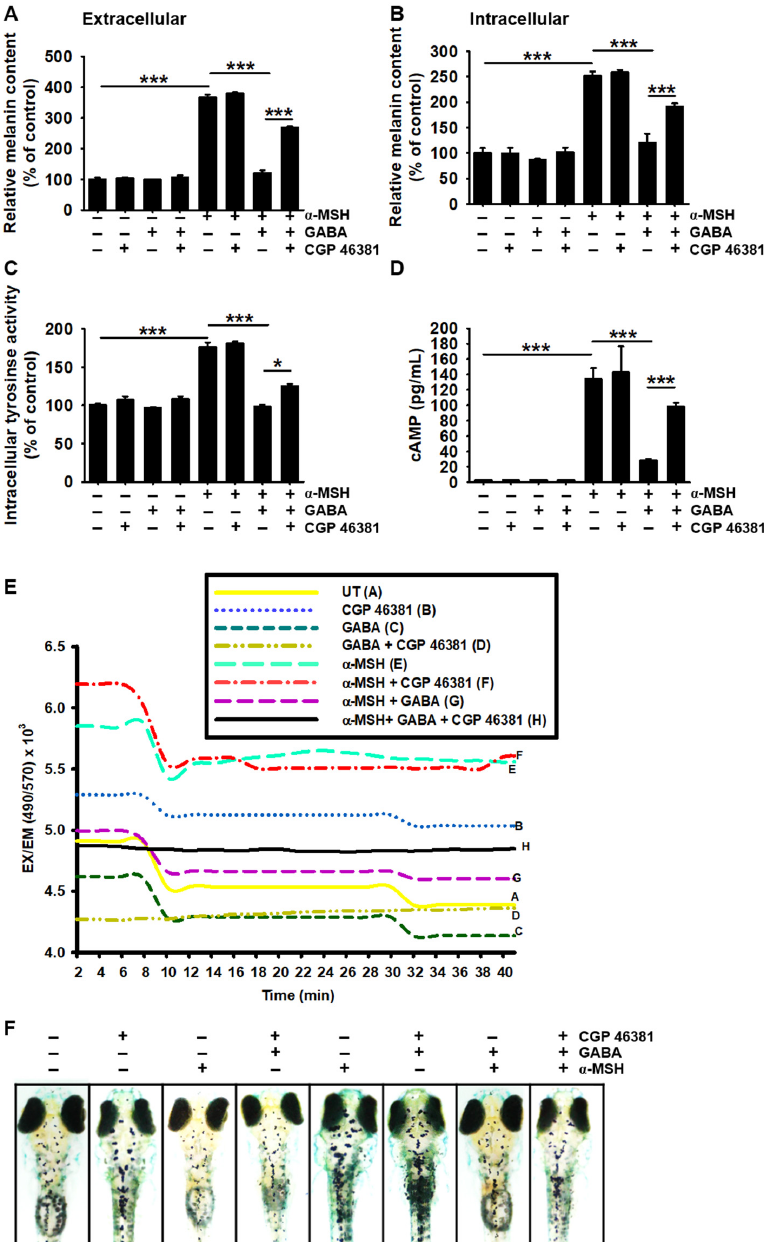
Figure 6. CGP 48381 reverses GABA-induced antimelanogenic effects in B16F10 melanoma cells and zebrafish larvae. B16F10 melanoma cells (5 × 10 4 cells/mL) were pretreated with 10 µ M CGP 46381 for 2 h prior to treatment with 20 mM GABA and 500 ng/mL α -MSH. Extracellular ( A ) and intracellular ( B ) melanin contents were measured. ( C ) Intracellular tyrosinase activity was measured 72 h after treatment with GABA and α -MSH, and ( D ) cAMP level was determined at 15 min. ( E ) The cells were stained with 1 µ M Fluo-4 AM for 10 min after treatment with GABA and/or α -MSH for 1 h, and fluorescence intensity was measured for 40 min using a luminometer. ( F ) Three days post-fertilized zebrafish larvae were pretreated with 10 µ M CGP 46381 for 2 h before treatment with 50 mM GABA and/or 1 µ g/mL α -MSH for an additional 72 h. Images were captured using a stereomicroscope (4 × ). The results represent the average of data obtained from three independent experiments and are expressed as the mean ± standard error of the mean (SEM) (*** p < 0.001 and * p < 0.01). GABA, gamma-aminobutyric acid; α -MSH, α -melanocyte-stimulating hormone; cAMP, cyclic adenosine